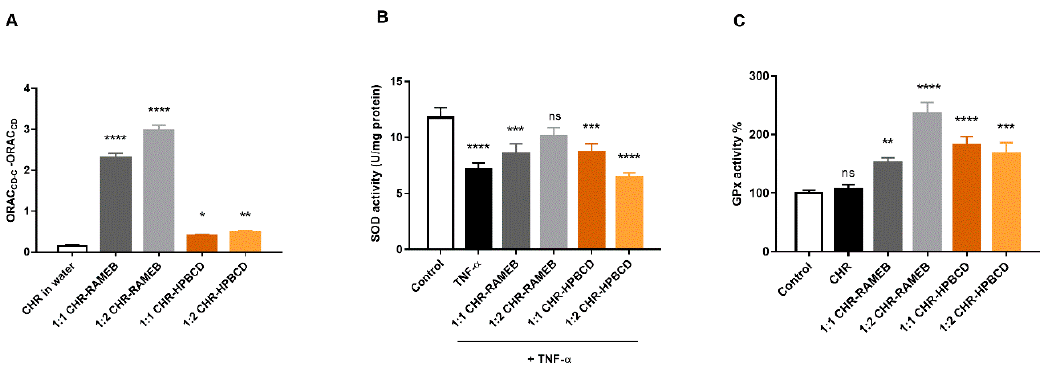
Figure 5. The effect of CHR and CHR–CD complexes measured in ORAC ( A ), SOD activity ( B ) and GPx ( C ) assays. Values were expressed as means ± S.D., n = 8–10, **** p < 0.0001, *** p < 0.001, ** p < 0.01, * p < 0.05, ns—non-significant. Values were compared to the value of CHR in water in the case of ORAC assay and to the untreated control in other assays.